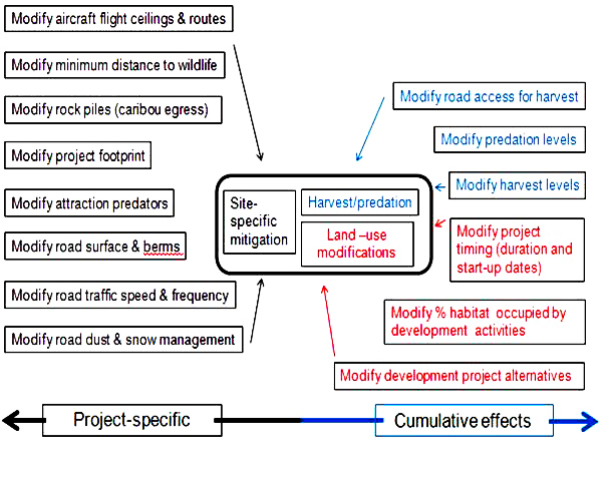
Fig. 4. The three categories and examples of cumulative effects mitigation: offset (harvest, predation), land use (modify the amount of landscape occupied by development over time and space), and project-specific